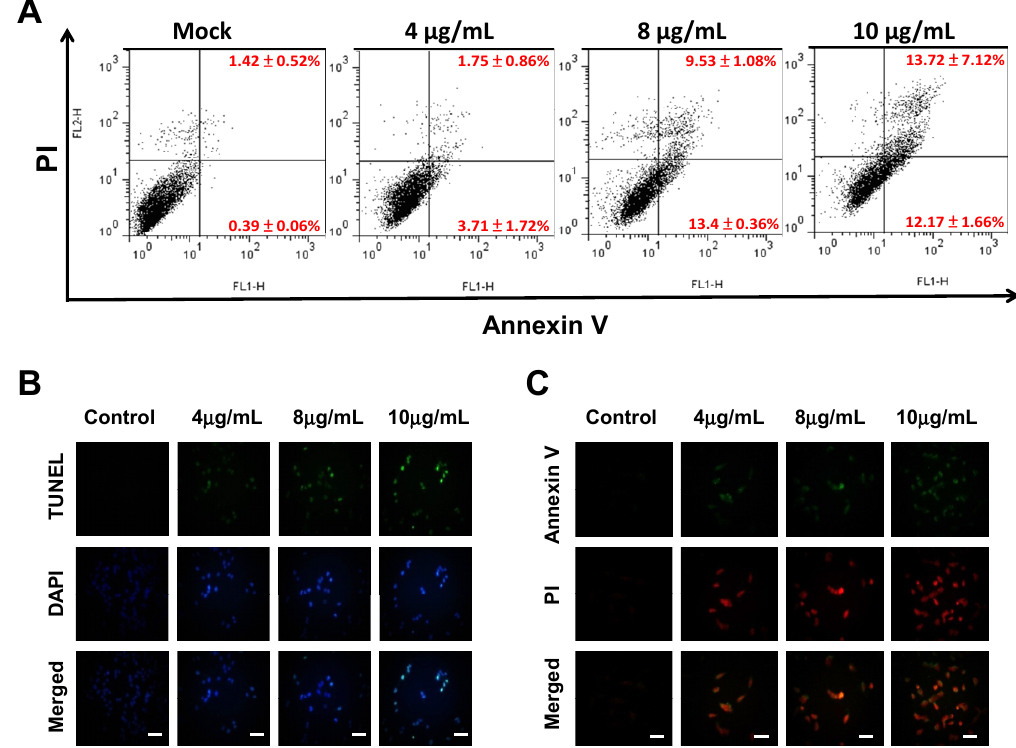
Figure 2. Sinulariolide-induced apoptosis of HA22T cells. ( A ) Detection of apoptotic HA22T cells after sinulariolide treatment (0, 4, 8 and 10 μ g/mL) by Annexin V- fluoresceinisothiocyanate (FITC)/porpidium iodide (PI) analysis. Sinulariolide induced early and late apoptosis in a dose-dependent manner. Bottom right quadrants, early apoptotic cells; top right quadrants, late apoptotic cells. ( B ) AnnexinV-FITC/PI analyses of apoptotic HA22T cells upon sinulariolide treatment. The HA22T cells were stained by PI (red) and Annexin-V (green) after different concentrations of sinulariolide treatment. ( C ) Detection of apoptotic cells by TUNEL and DAPI staining assay. HA22T cells were treated with sinulariolide at the final concentration of 4, 8 and 10 μ g/mL for 24 h. The cells were harvested for TUNEL and DAPI staining as described in the Experimental section. Scale bar = 50 μ